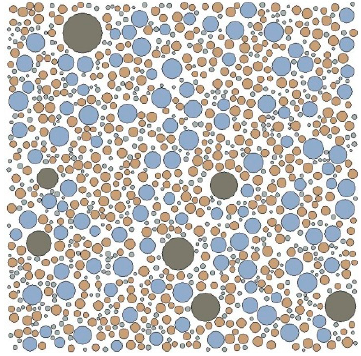
Figure 2. 2D RCA structure of mortar.